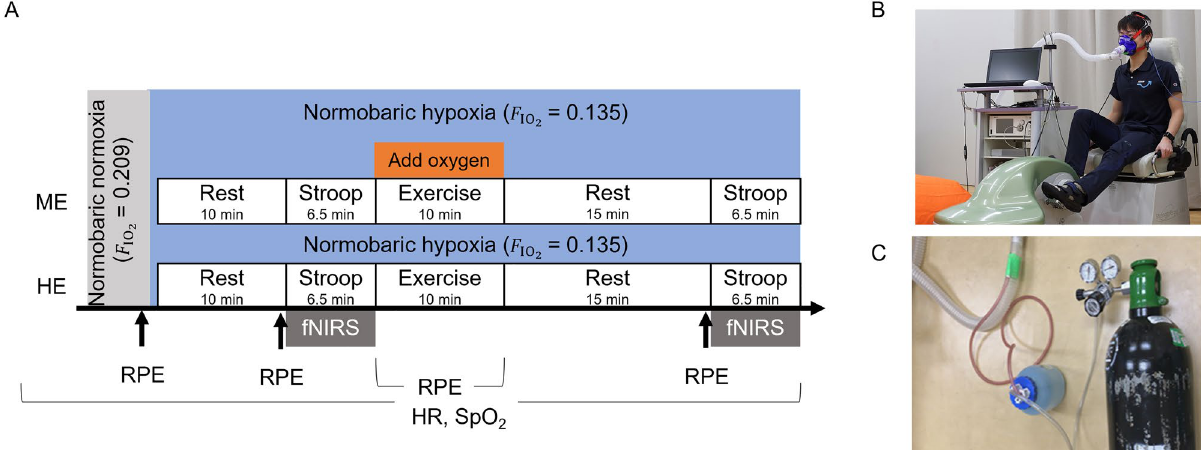
Figure 5. ( A ) The two conditions, breathing a moderately hypoxic gas (hypoxic exercise [HE]) and breathing a milder hypoxic gas, during which oxygen was added to the moderately hypoxic gas to maintain the oxygen saturation (SpO 2 ) level during milder hypoxic exercise (ME). Cortical hemodynamic changes were monitored with functional near-infrared spectroscopy (fNIRS) while participants performed the Stroop task. HR, heart rate. ( B ) In both conditions, the exercise and color-word Stroop task (CWST) were performed on a recumbent cycle ergometer. Hypoxic gas ( F IO 2 = 0.135) stored in a Douglas bag was inhaled through a mask. ( C ) In the ME condition, SpO 2 was adjusted during exercise by adding oxygen gas with humidity to prevent the participant’s throat from drying out to the hose connecting the Douglas bag to the breathed a moderately hypoxic gas during the CWST, but only during exercise; they breathed a milder hypoxic gas ( F IO = 0.161 ± 0.018) to regulate the hypoxic gas so their SpO 2 did not decrease from the resting state. To adjust 2 the oxygen concentration, oxygen was injected directly into the hose while monitoring the SpO 2 during exercise. Expired air was exhausted directly outside the mask so participants did not re-breathe it. The participants were exposed to a moderately hypoxic gas 10 min before the pre-Stroop session while sitting on a cycle ergometer. HR was monitored by a heart rate monitor (V800, Polar Electro, Kempele, Finland), SpO 2 was monitored by a pulse oximeter (OLV-3100, Nihon Kohden, Tokyo, Japan) placed on the left earlobe, and exhaled gas was monitored every minute by a gas analyzer (Aeromonitor AE-310S; Minato Medical Science, Osaka, Japan). The participants’ RPE 37 were recorded before exposure to hypoxia, every minute during exercise, and before the CWST. Behavioral measurements. The CWST 1–3,8,15,38–42 was adopted in an event-related design. The CWST, which included two rows containing letters or words, was presented on a screen, and the participants were instructed to decide whether the color of the letters or words in the top row corresponded to the color name presented in the bottom row. Participants pressed a “yes” or “no” button with their right forefinger or middle finger to respond. The RT and error rates were measured. The CWST consisted of three trials, including 10 neutral, 10 congruent, and 10 incongruent trials. For neu- tral trials, the top row contained sets of X’s (XXXX) written in red, blue, green, or yellow, and the bottom row contained the words “RED,” “BLUE,” “GREEN,” or “YELLOW” written in black. For congruent trials, the top row contained the words “RED,” “BLUE,” “GREEN,” or “YELLOW” written in a color congruent with that of the bottom row. For incongruent trials, the color word in the top row was written in an incongruent color to produce interference between the color of the word and the color name. All words were written in Japanese. The correct answer rate assigned to “yes” and “no” was 50%. Each stimulus was separated by an inter-stimulus interval showing a fixation cross for 9–13 s to avoid predicting the timing of the subsequent trial 1,2,8,15,38–40,42 . The stimulus remained on the screen until a response was given or for 2 s. In the present study, Stroop interference, a specifically defined cognitive process, was used to elucidate the effect of an acute bout of moderate exercise under hypoxic conditions on executive function. Therefore, the (incongruent-neutral) contrast, which is assumed to represent Stroop interference, was calculated. fNIRS measurements. We used a multichannel fNIRS optical topography system (ETG-7000, Hitachi Medical Corporation, Chiba, Japan) set with two wavelengths of near-infrared light (785 and 830 nm). We analyzed the optical data from fNIRS based on the modified Beer–Lambert law 43 , as previously described 44 . This method allowed us to calculate signals reflecting the oxy-Hb, deoxy-Hb, and total hemoglobin concentration changes, calculated in millimolar-millimeters (mM ⋅ mm) 44 . The composition of the fNIRS probe holder and its placement followed the same procedure used in our previous studies 1–3,8,38–40,42,45 . To register fNIRS data in the Montreal Neurological Institute (MNI) space, we used virtual registration 46,47 . Briefly, this method enables the placement of a virtual probe holder on the scalp by stimulating the holder’s deformation and registering probes and channels onto a reference brain in a preconstructed magnetic resonance imaging database 48,49 . We probabilistically estimated the MNI coordinate values for the fNIRS channels to obtain the most likely estimate